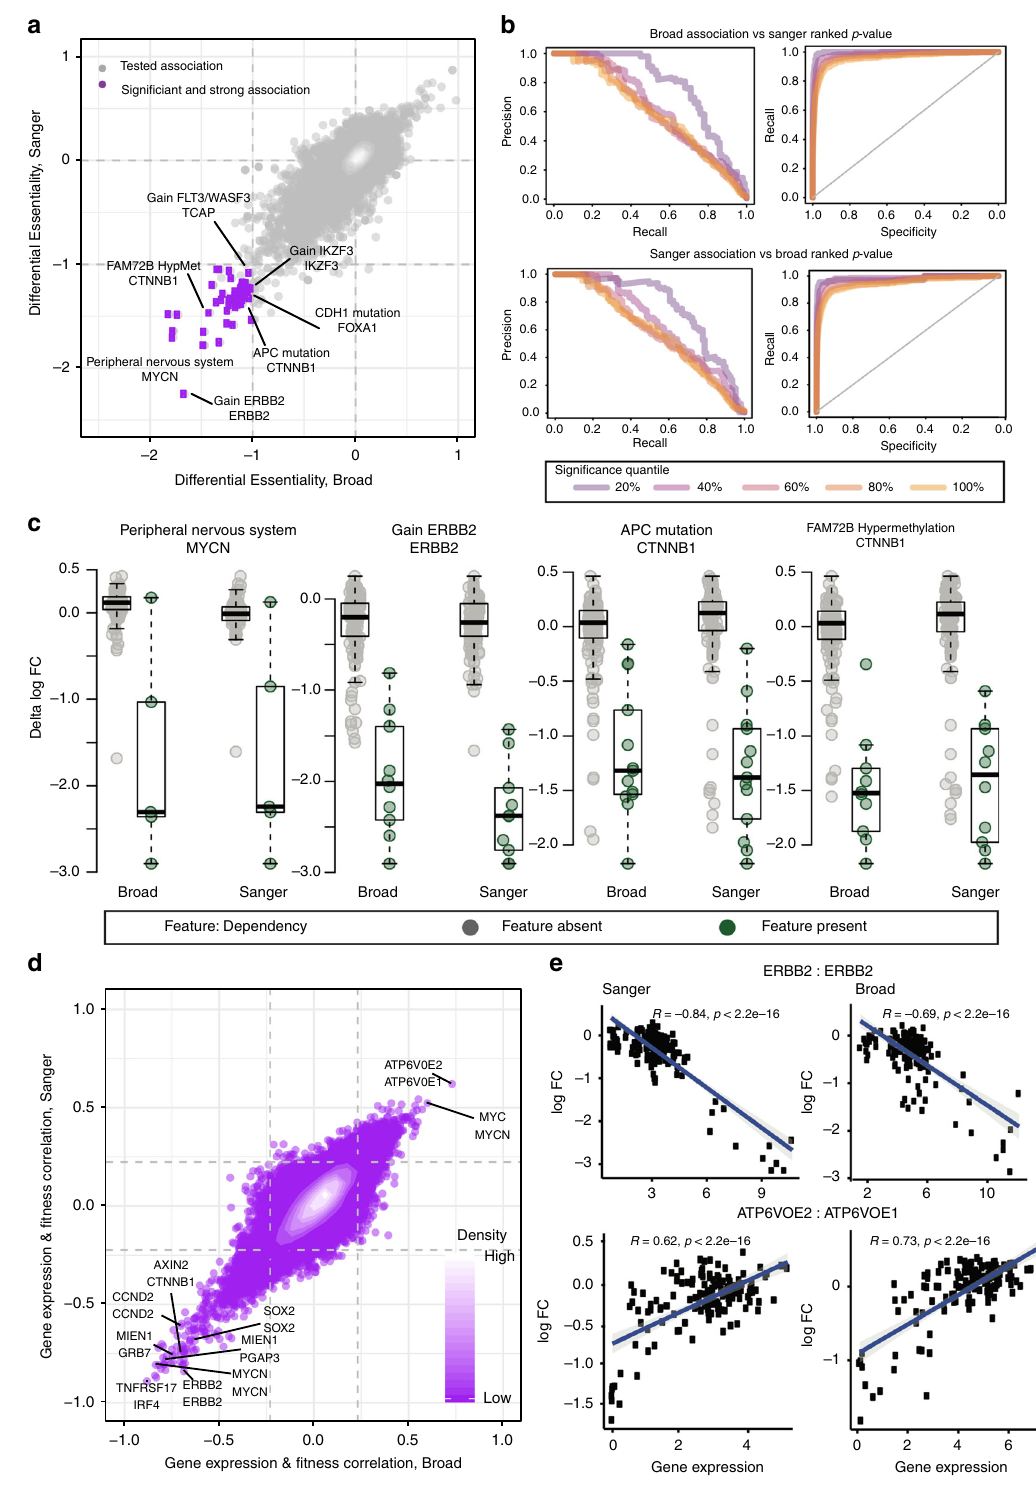
with 4,459 (52% of Broad and 66% of Sanger gene expression biomarkers) found signi fi cant for both studies, out of 97,363 tested (Fisher ’ s exact test p -value below machine precision), and strong overall agreement of correlation scores between gene expression markers and SSD genes dependency across data sets